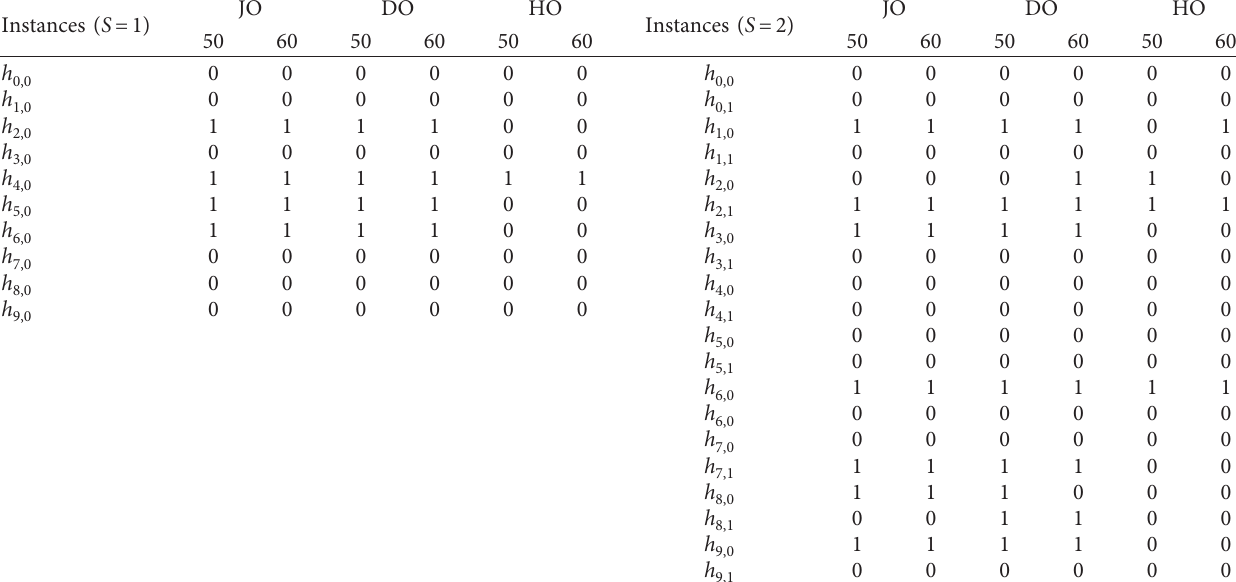
Table 5: Network configurations of JO, DO, and HO algorithms in 60 Mbps when S � 1 ,